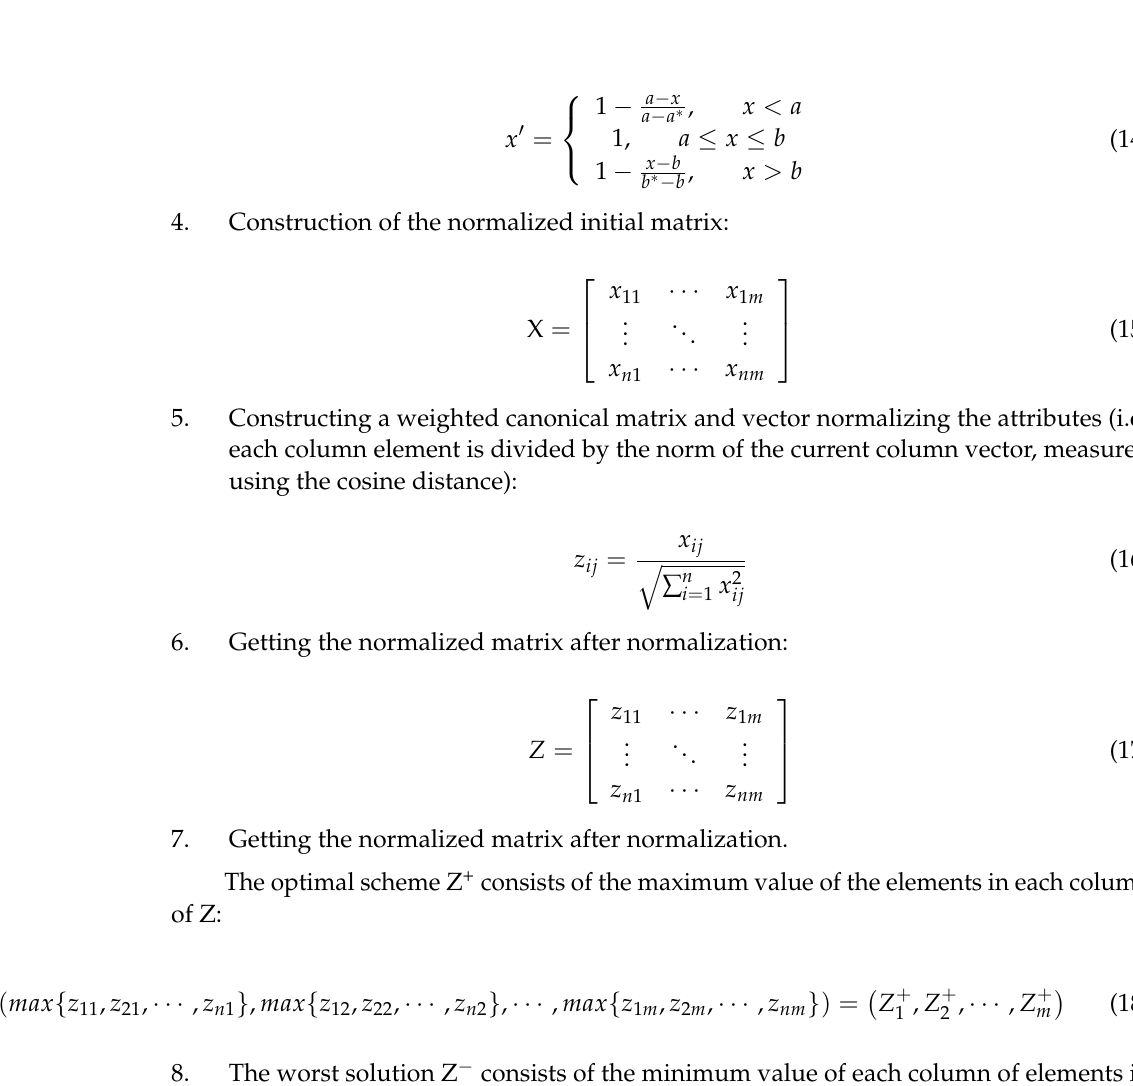
9. The approximate degree of each evaluation object to the optimal and the worst scheme was calculated: